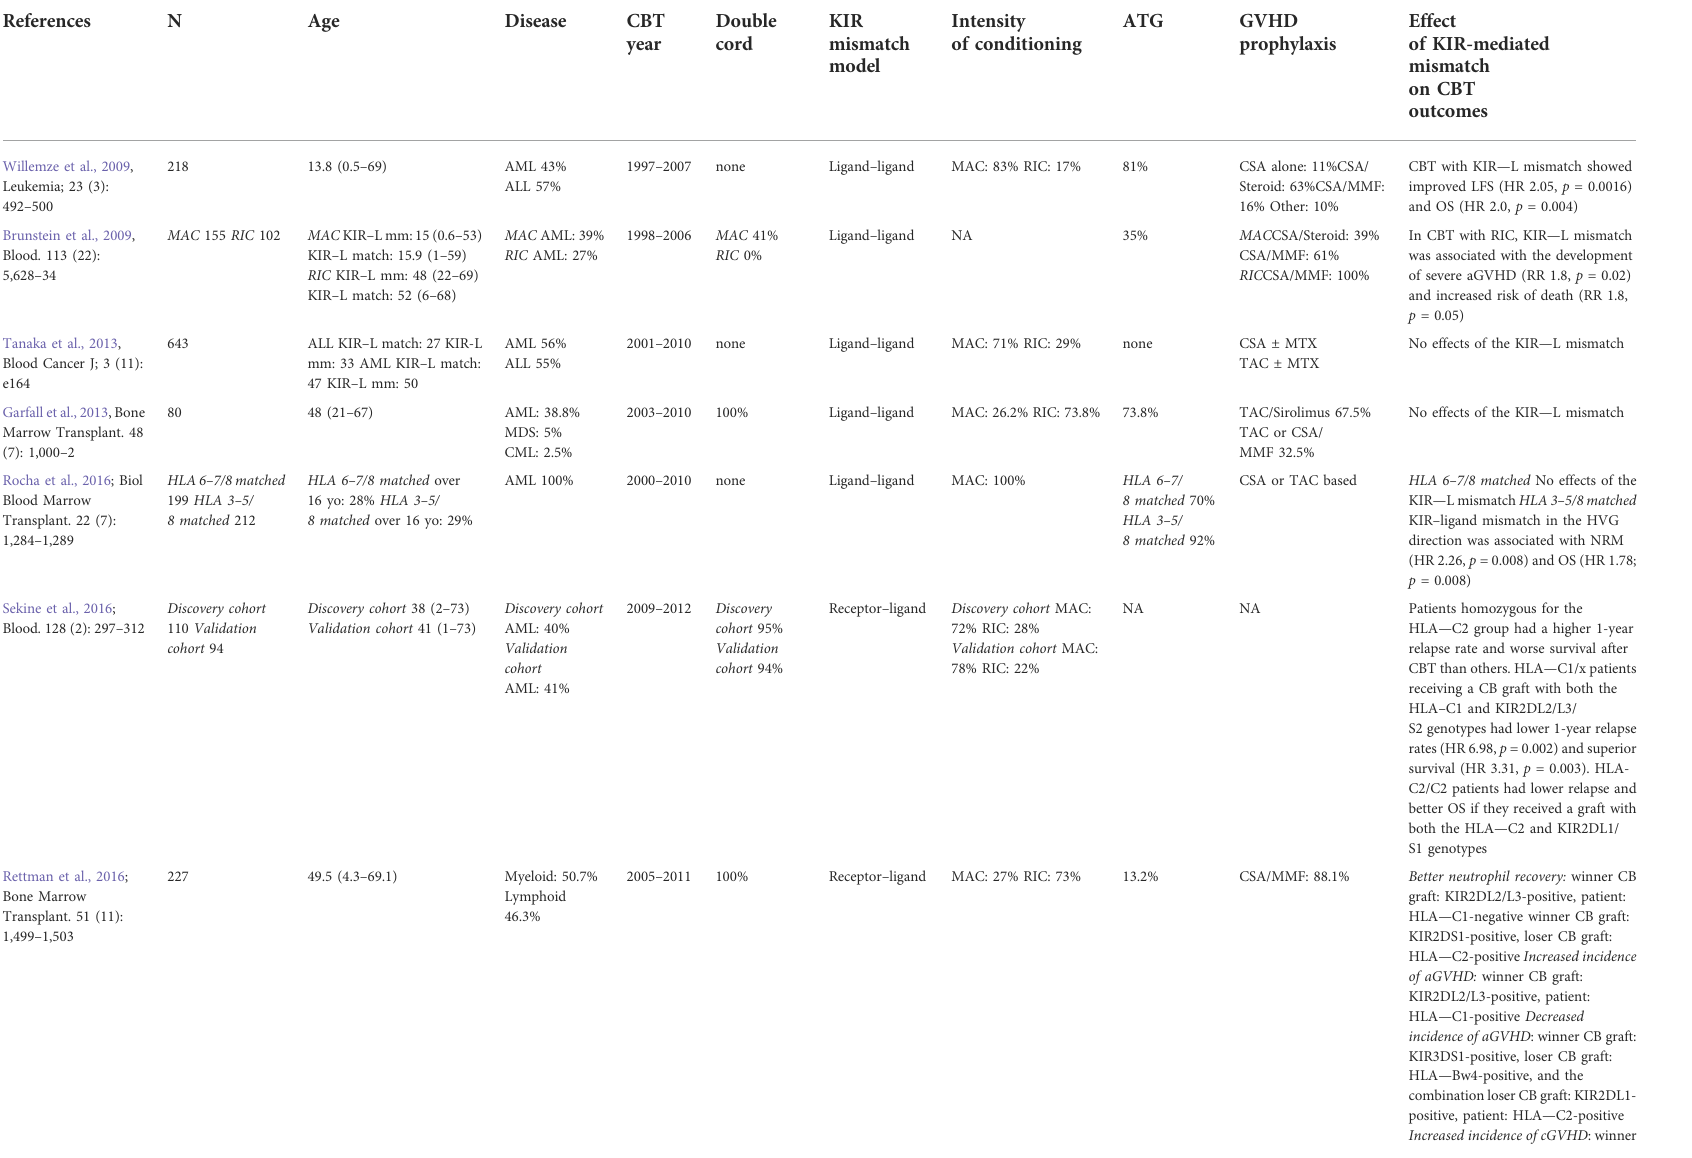
TABLE 2 Cord blood transplantation (CBT) outcomes resulting from the KIR – ligand